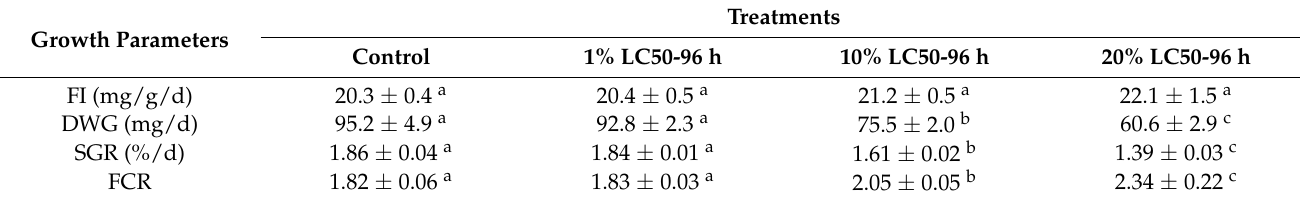
Table 5. Growth performances of B. gonionotus after 60